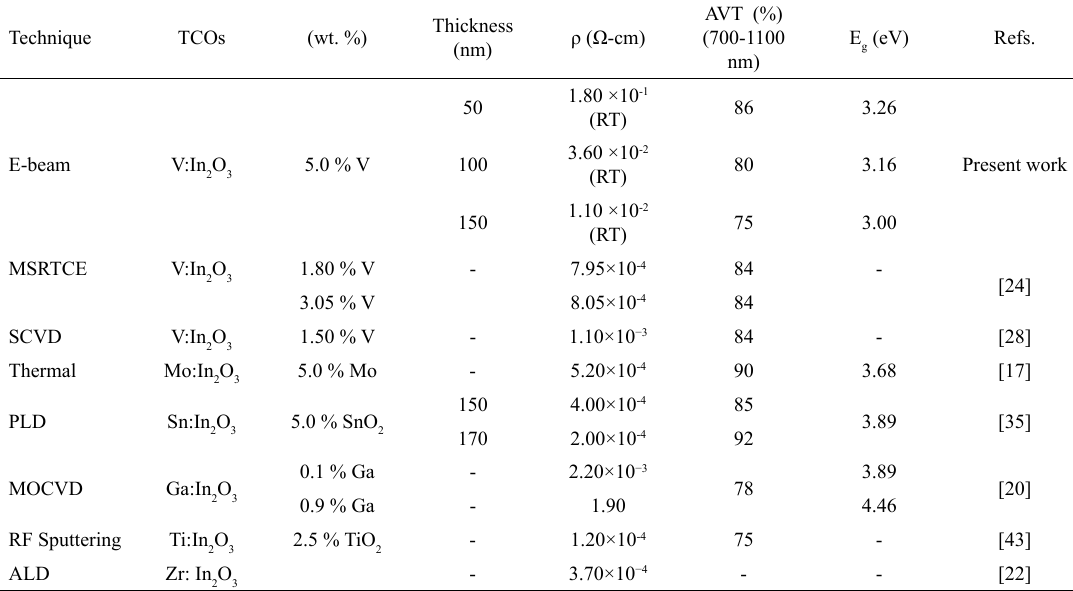
O thin films with previous reported works of different TCO films by 2 3